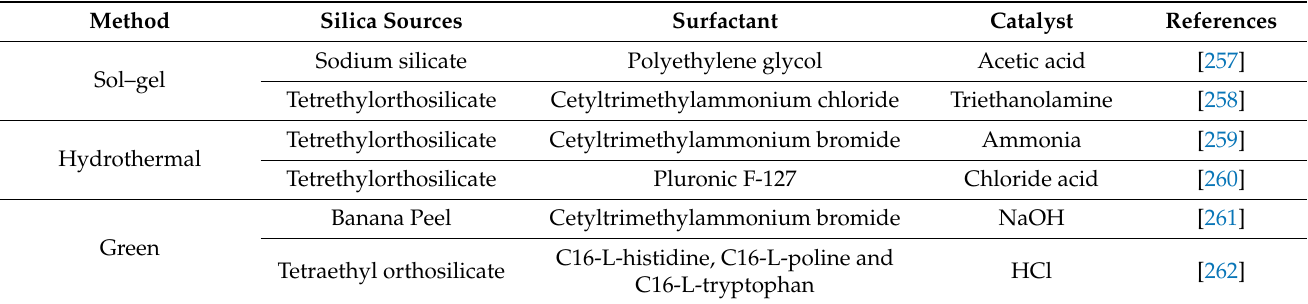
Table 9. Three different synthesis methods of